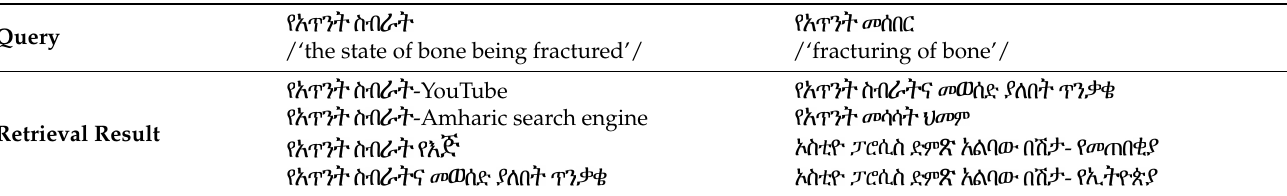
Table 13. The top 4 search results from Google Amharic for two